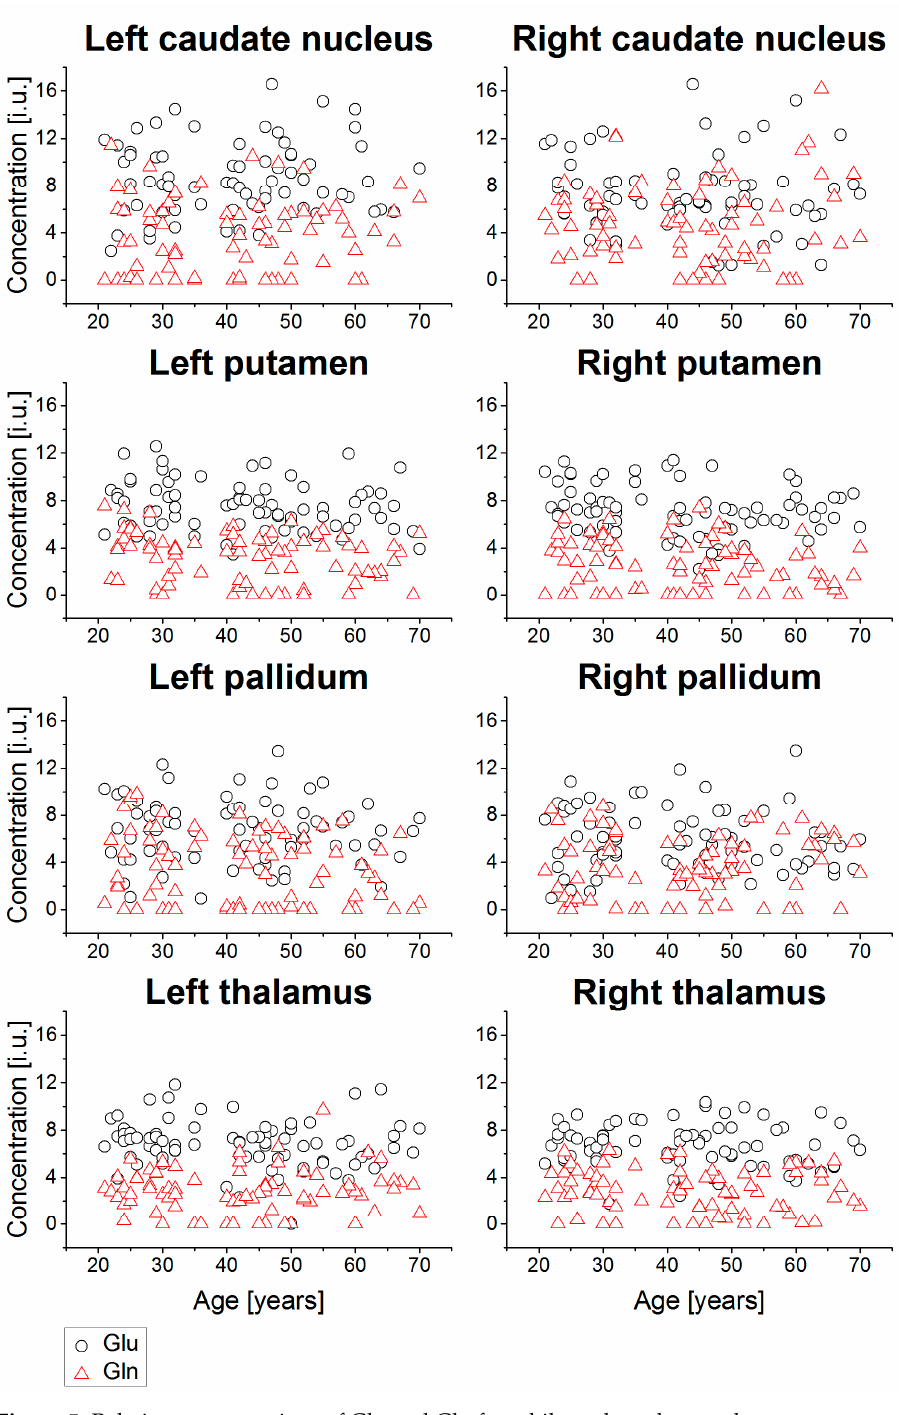
Figure 5. Relative concentrations of Glu and Gln from bilateral caudate nucleus, putamen, pallidum, and thalamus of all subjects, shown as a function of age. The values are presented in institutional unit (i.u.) normalized using the signal from tissue water.